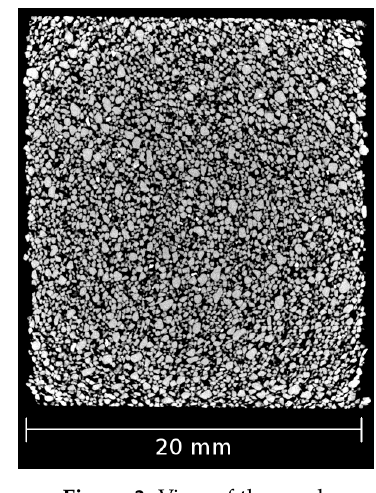
Figure 3. View of the sand.